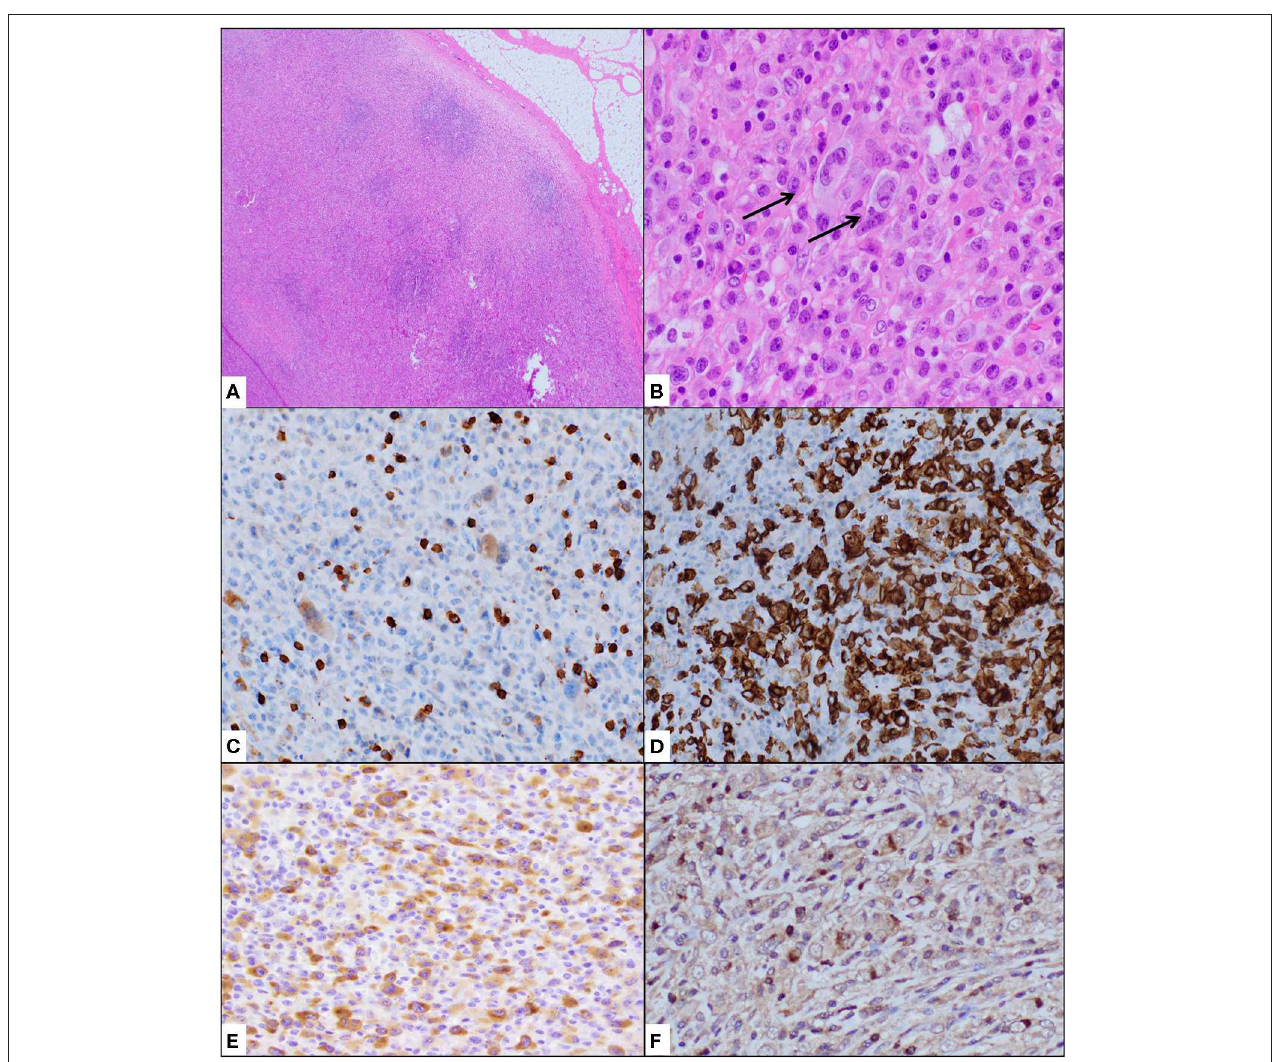
FIGURE 1 | Cervical lymph node biopsy showed effacement of architecture (A) with atypical cells, often containing “hallmark” cells with kidney-shaped nuclei (B) . Immunohistochemical stains showed these neoplastic cells to be weak or negative for CD3 (C) and strongly positive for CD30 (D) . ALK1 immunostain showed granular cytoplasmic positivity (E) while TIA1 was variably positive (F) . Staining for histiocyte CD68 showed increased histiocytes.